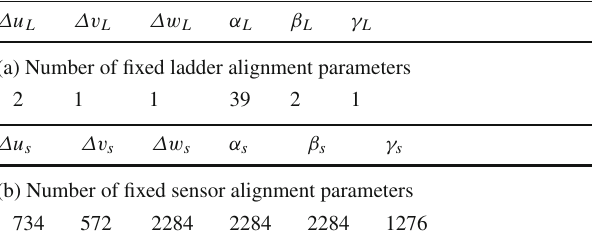
Table 2 The number of ladders (a) and sensors (b) with fixed param- eters in the test-beam alignment. Note that the AMS tracker has